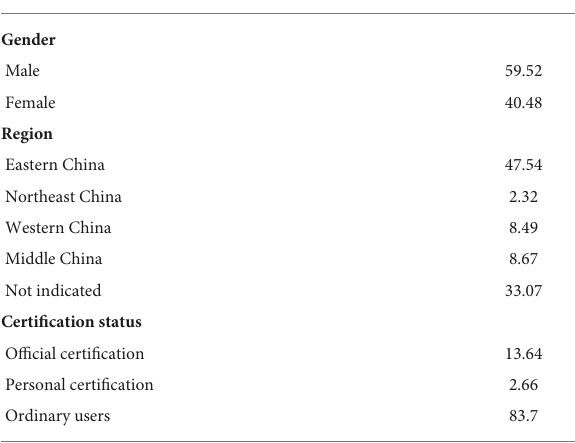
TABLE 2 Perceived subject characteristics of waste classification policy.